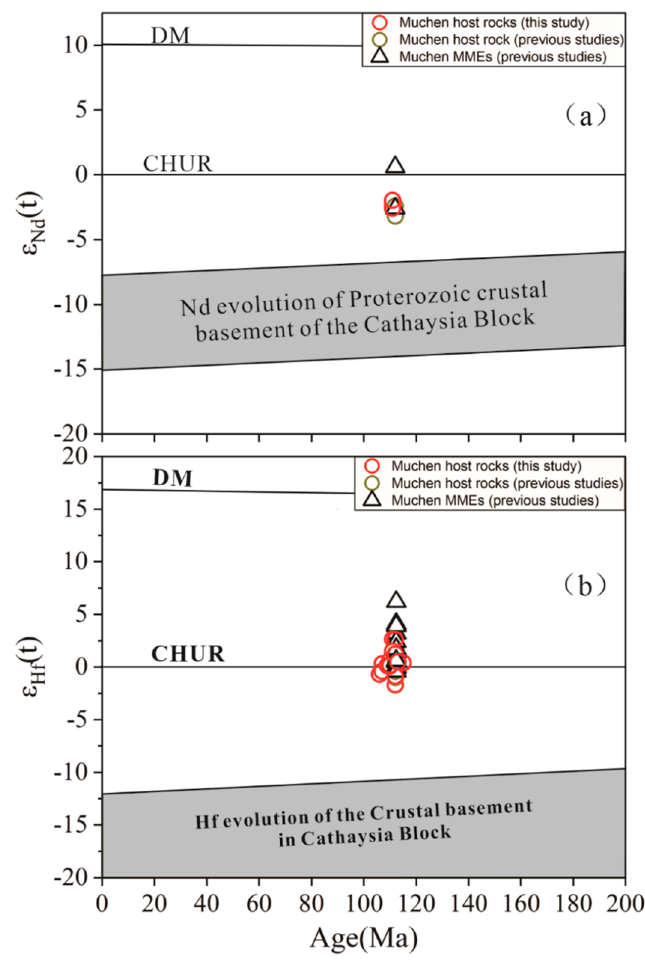
Figure 14. Nd and Hf isotope diagram of Muchen pluton. The Nd isotope evolution for Cathaysia Figure 15. Nd and Hf isotope diagram of Muchen pluton. ( a ) The Nd isotope evolution for Cathaysia crustal basement are from Chen and Jahn [37]. Hf isotope evolution for Cathaysia crustal basement crustal basement are from Chen and Jahn [37]. ( b ) Hf isotope evolution for Cathaysia crustal basement are from Xu et al. [106] and He et al. [107]). are from Xu et al. [106] and He et al.